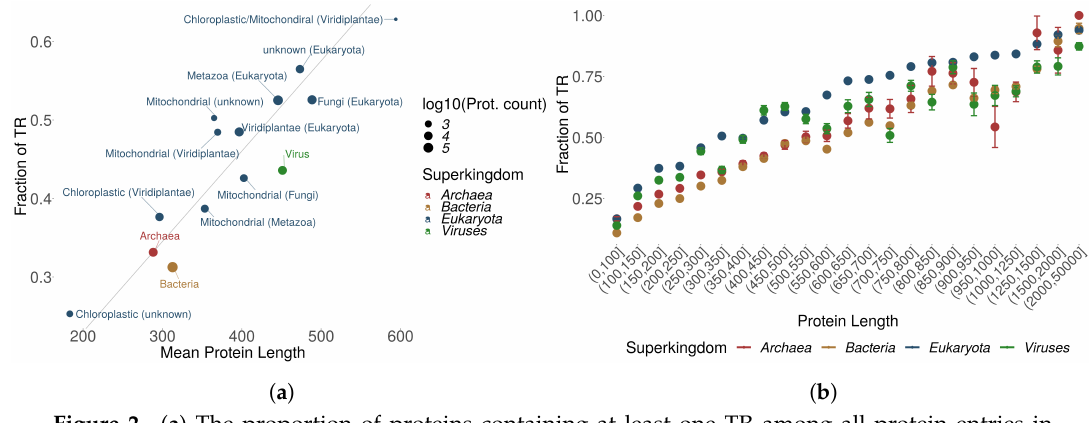
Figure 2. ( a ) The proportion of proteins containing at least one TR among all protein entries in UniProtKB/Swiss-Prot is shown as “proportion of TRs” for each superkingdom or kingdom, displayed as function of the mean protein length and split according to the origin of the proteins. ( b ) The proportion of proteins with TRs as a function of sequence length by